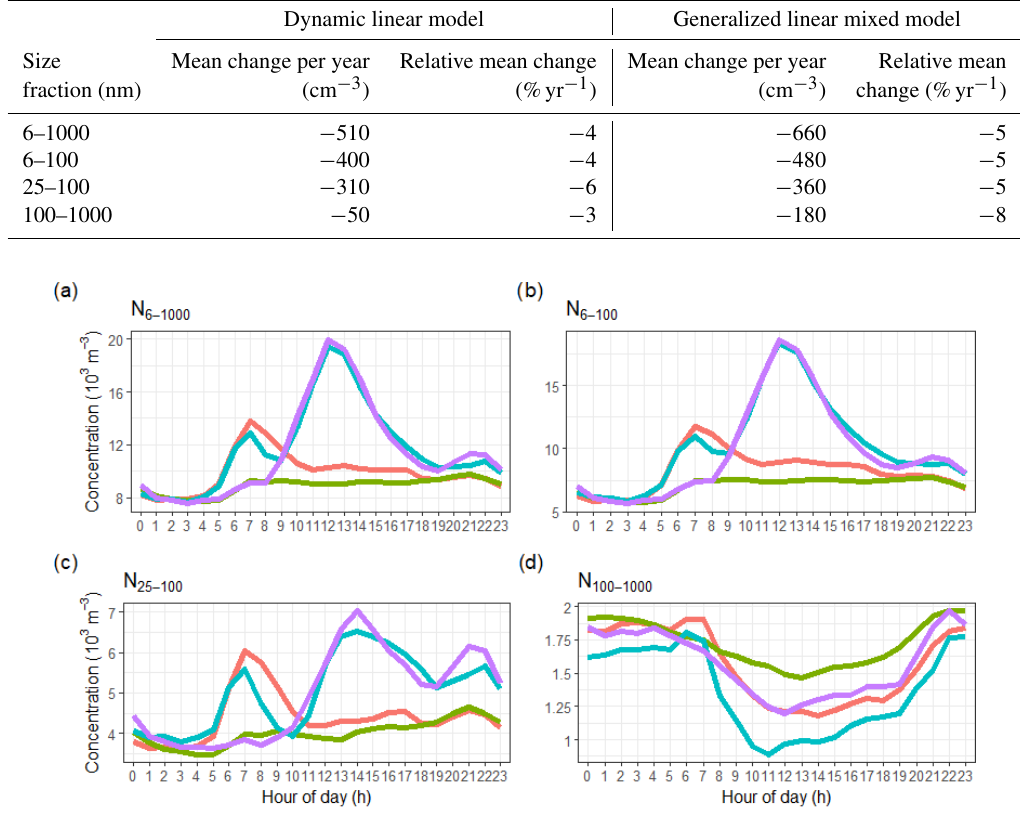
Figure 3. Diurnal patterns of particle number concentrations in the diameter ranges from 6 to 1000nm ( N 6 − 1000 ), from 6 to 100nm ( N 6 − 100 ), from 25 to 100nm ( N 25 − 100 ) and from 100 to 1000nm ( N 100 − 1000 ) (with factor and unit of × 10 3 cm − 3 ). Red: non-event on workdays, green: non-event on holidays, cyan: event on workdays, purple: event on